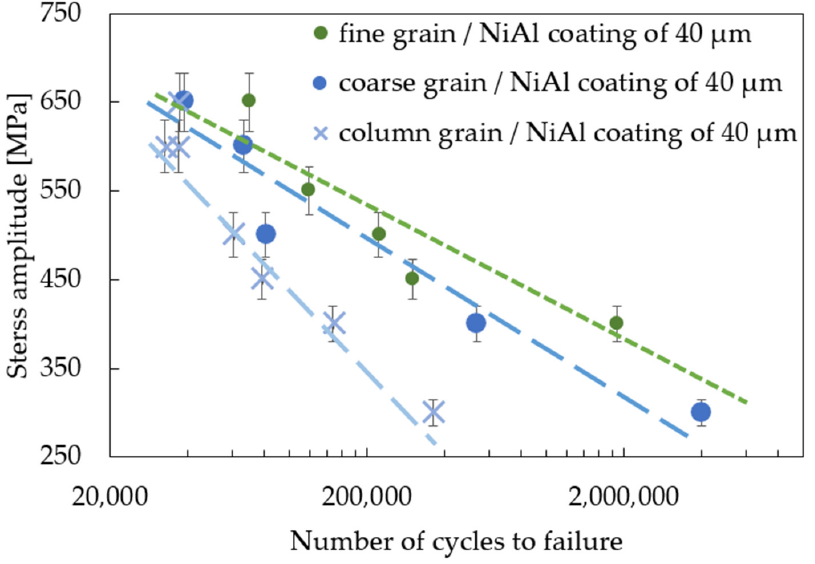
Figure 9. S-N curves for the MAR 247 nickel-based superalloy coated with 40 µm-thick NiAl.